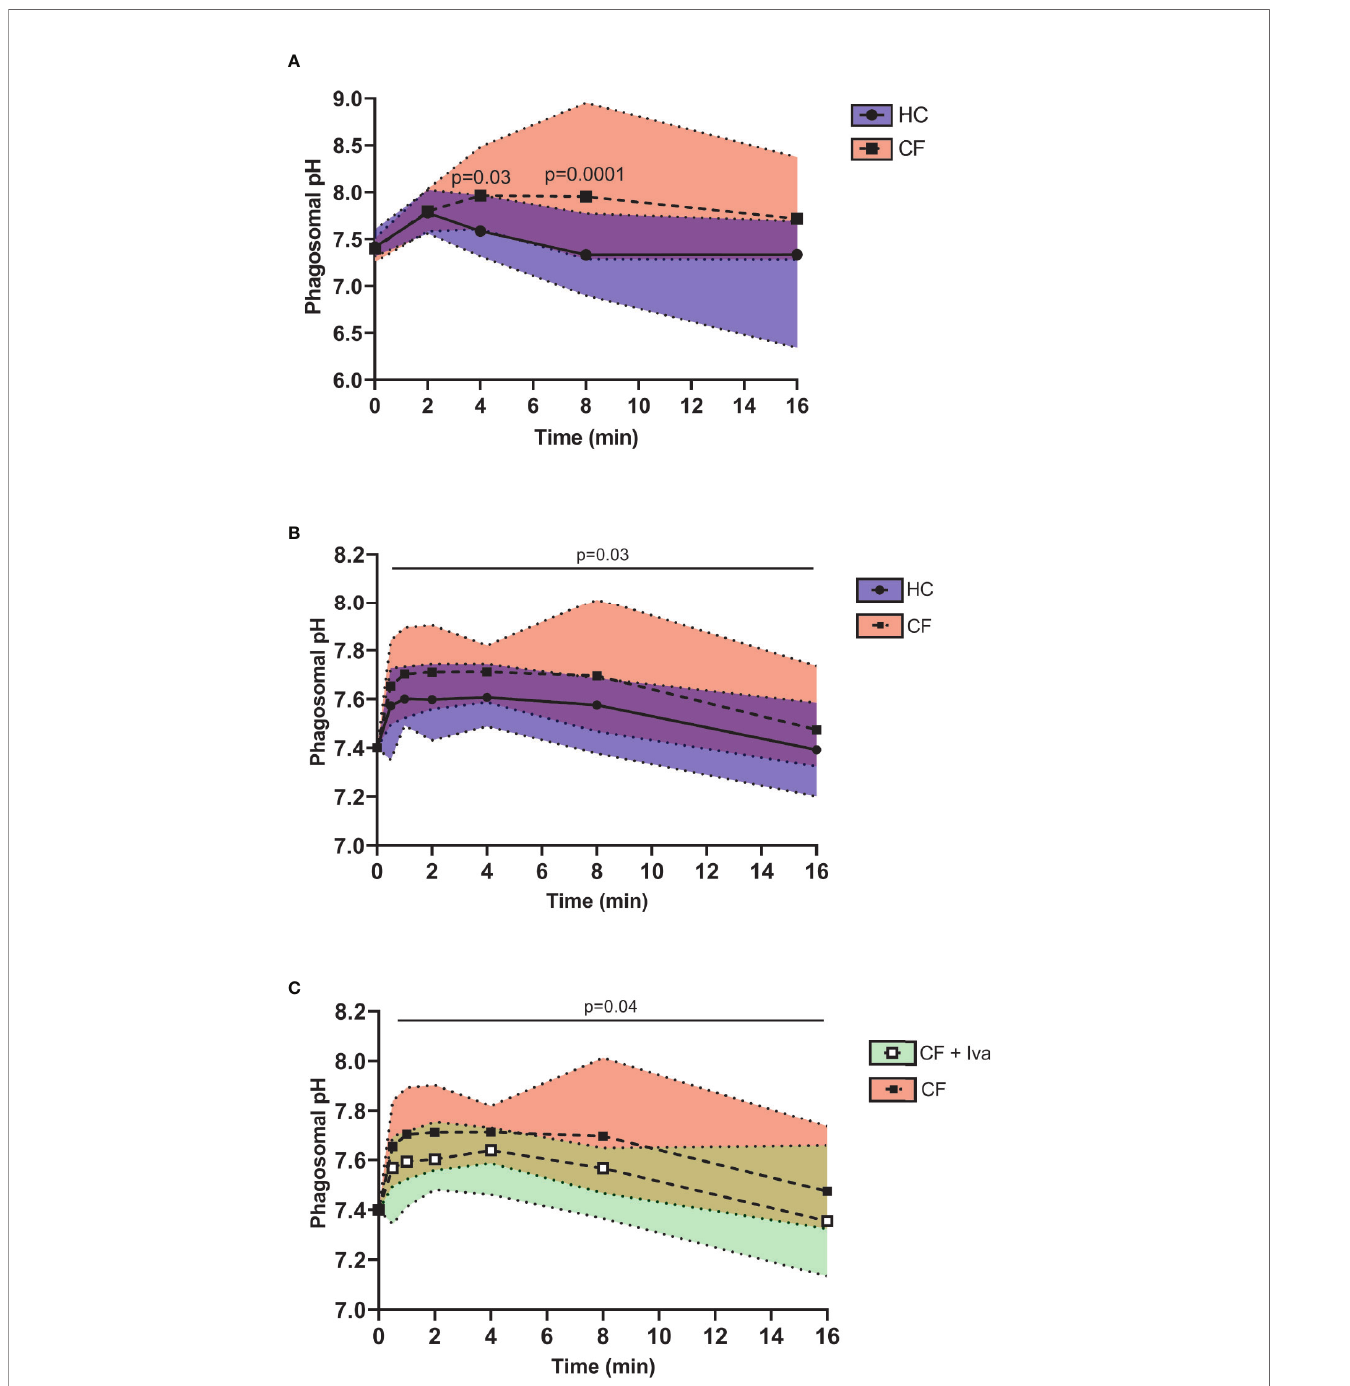
FIGURE 4 | Prolonged alkalinity of CF phagocytic vacuoles. (A) Phagosomal pH was assessed using the pH sensitive fl uorescent probe BCECF-AM. Signi fi cantly increased phagosomal pH was measured in CF neutrophils compared to HC post phagocytosis of probe labelled S. aureus (n = 3 subjects per group, two-way ANOVA with S ̌ ı ́ da ́ k post hoc test). (B) Time course of phagosomal pH changes assessed using SNARF labelled C. albicans , phagocytosed by neutrophils of HC, or Phe508del homozygous CF neutrophils. Phagosomes of Phe508del CF neutrophils demonstrated signi fi cantly increased pH (n = 3 subjects per group, mixed effects model with Tukeys ’ post hoc test). (C) Time course of phagosomal pH changes assessed using SNARF labelled C. albicans , phagocytosed by neutrophils of Phe508del homozygous CF neutrophils (as per data presented in panel B ) or neutrophils from Gly551Asp PWCF receiving ivacaftor therapy (CF+Iva). Phagosomes of Phe508del CF neutrophils demonstrated signi fi cantly increased pH (n = 3 subjects per group, mixed effects model with Tukeys ’ post hoc